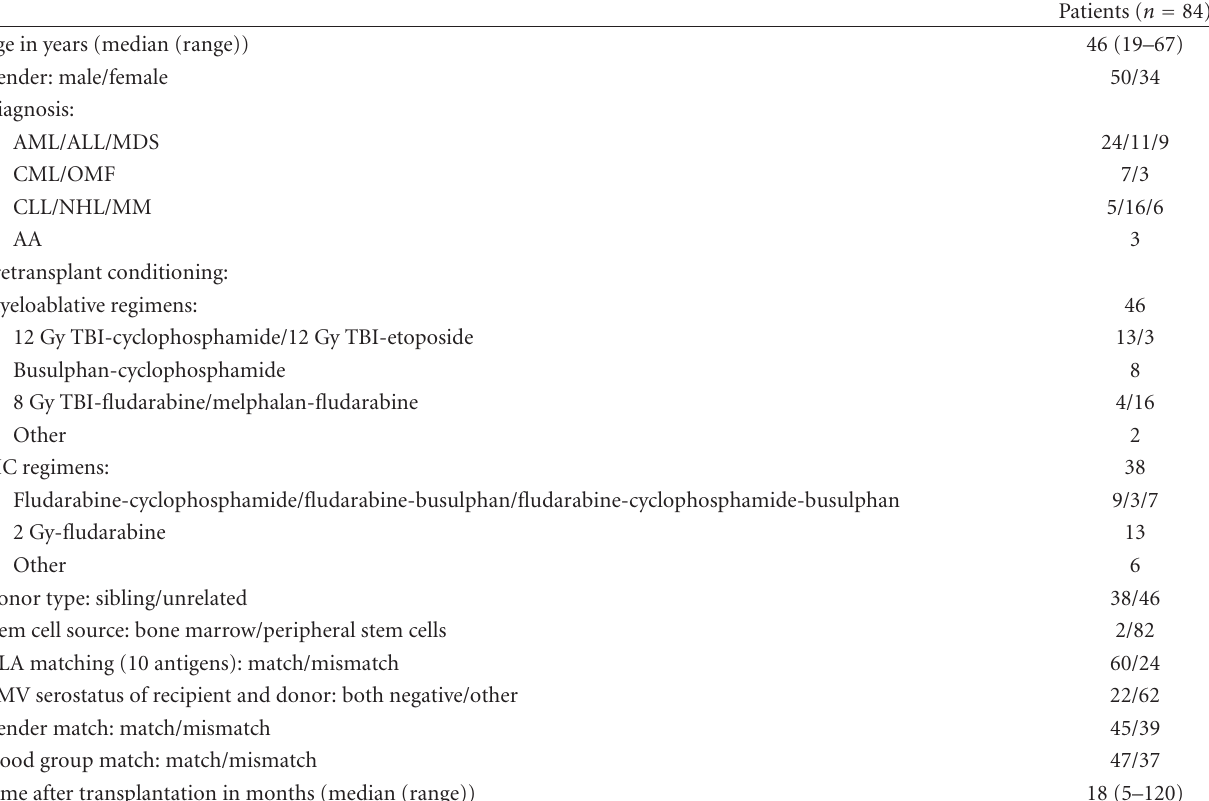
Table 1: Patient characteristics and transplantation